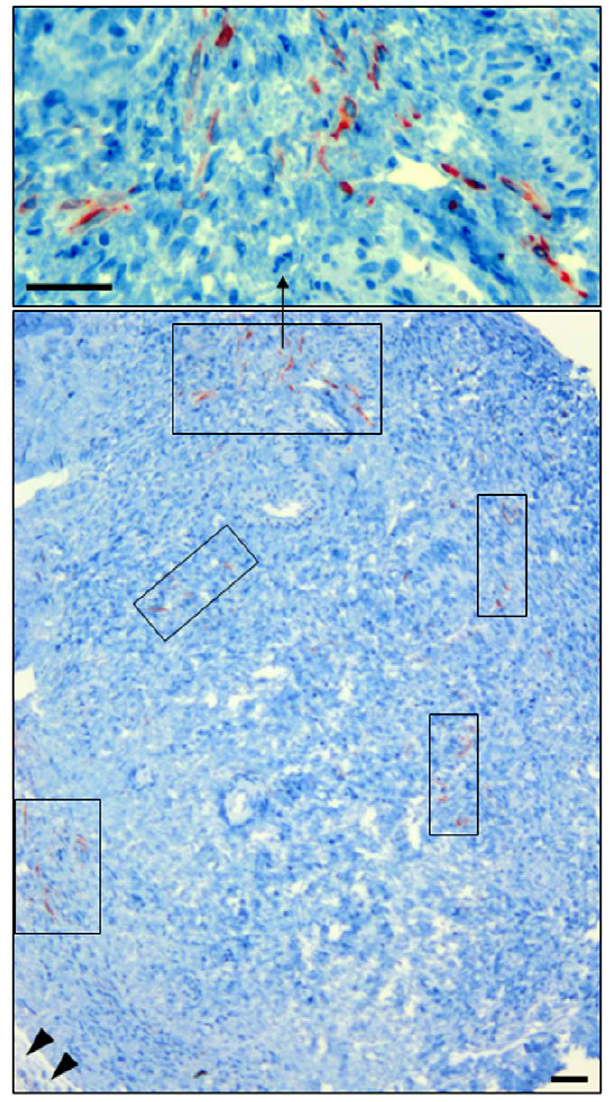
Figure 6. Neo-angiogenesis (desmin expression) in cryopre- served medulla-containing ovarian tissue after CAM-culture. (rectangles) places where neo-angiogenesis was detected, (head arrow) CAM. Bar=25 m m.